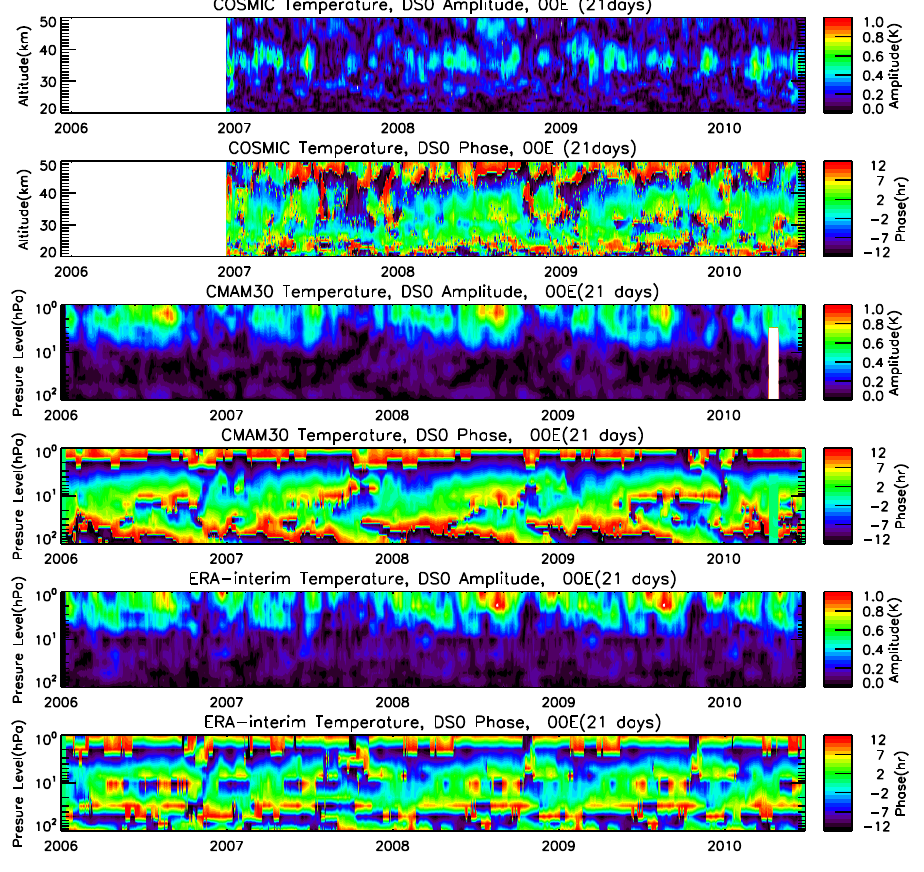
Figure 1. Amplitudes and phases of DS0 tide over equator from COSMIC observations, CMAM30, and ERA-interim reanalysis datasets using ± 10 days